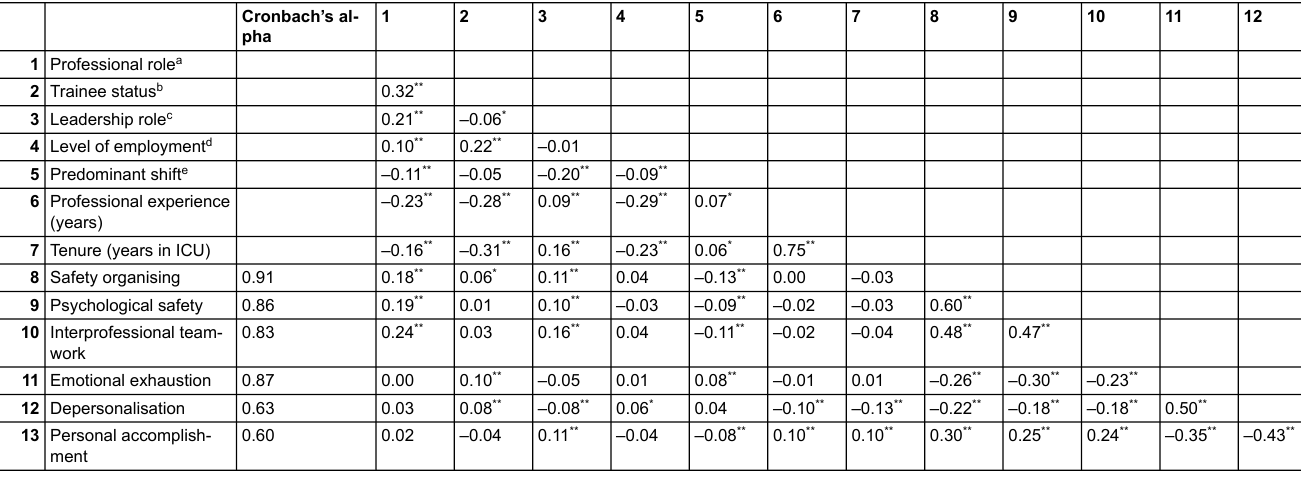
Table S1: Individual-level Pearson correlations between demographic characteristics, and teamwork (safety organising, psychological safety, interprofessional teamwork) and burnout (emotional exhaustion, depersonalisation, personal accomplishment).